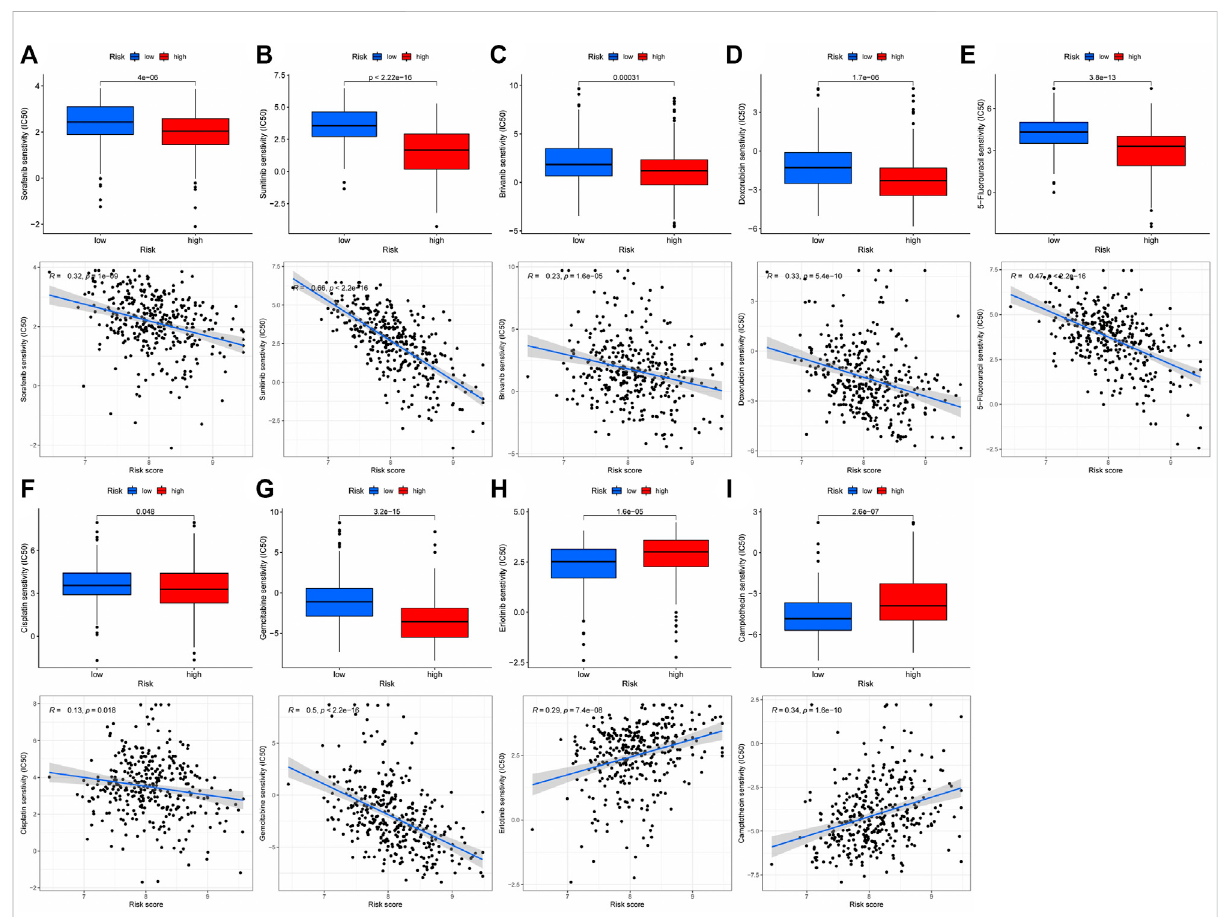
FIGURE 7 The treatment sensitivity analysis of HCC clinical commonly used drugs in patients with different risk scores (A – I) Correlation and sensitivity between differentriskscoresanddrugtreatmenteffect; (A) Sorafenib; (B) Sunitinib; (C) Brivanib; (D) Doxorubicin; (E) 5-Fluorouracil; (F) Cisplatin; (G) Gemcitabine; (H) Erlotinib; (I)